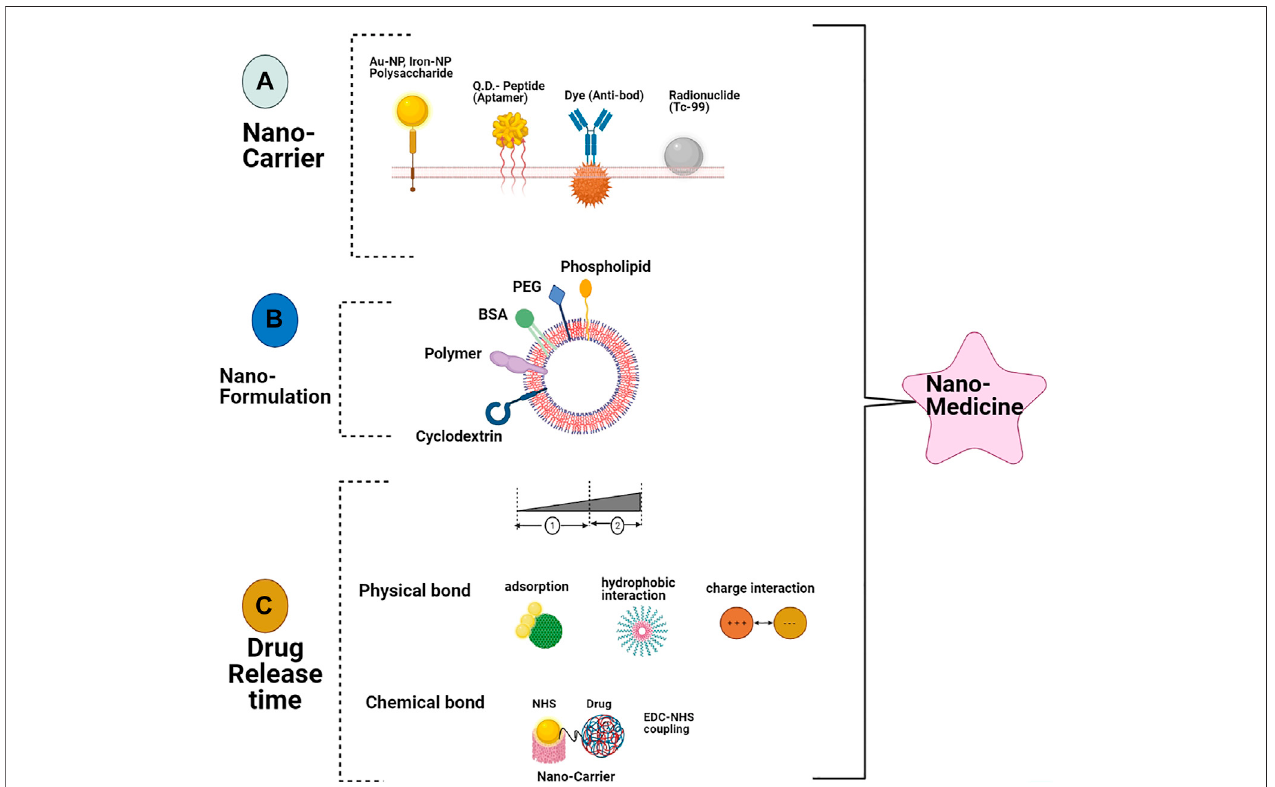
FIGURE 2 | Schematic explanation role of nanotechnology in CRC. (A) NPs routes for administration, (B) various kinds of polymer NPs and metallic along with necessary parameters for use in CRC therapy cancer therapy (C) screening and detecting the tumor respectability using multimodal imaging and involvement of increased permeability and retention effect on antitumor drug synthesis for CRC targeting